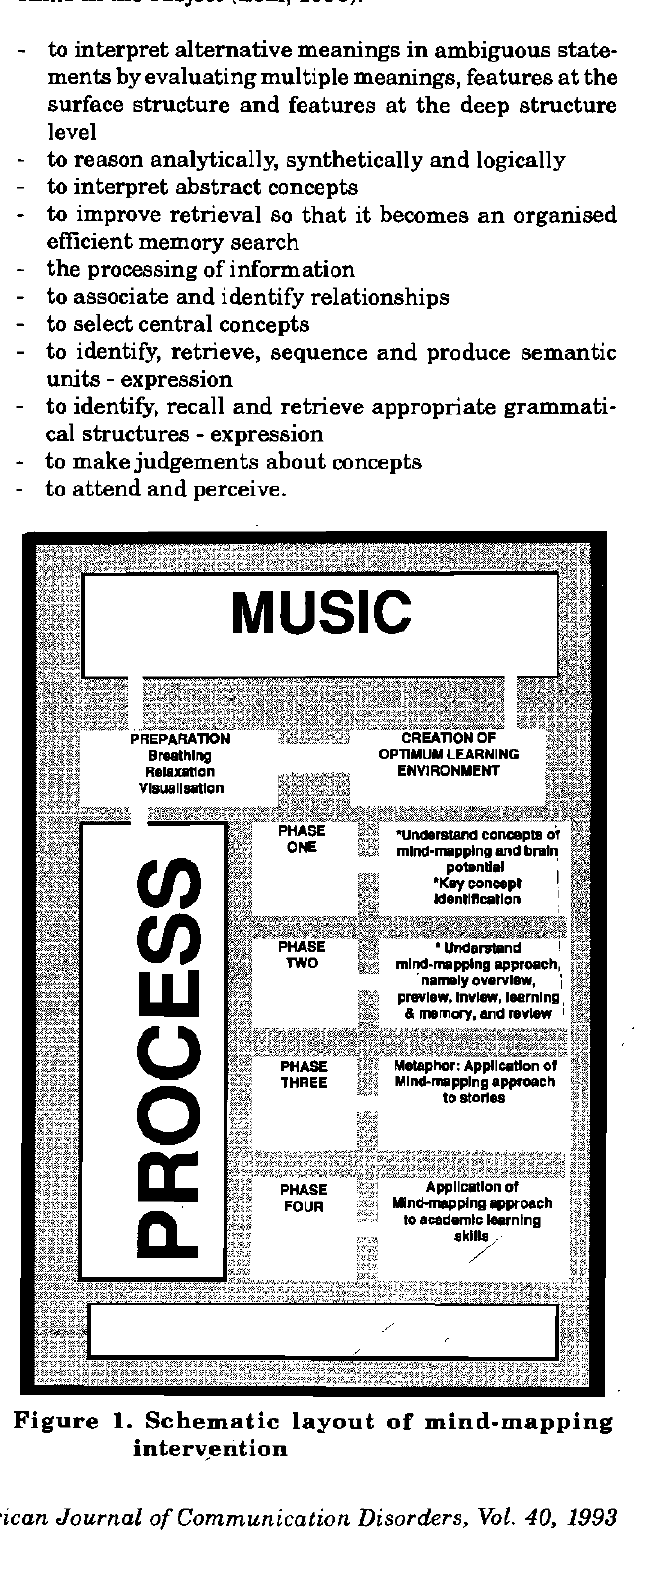
Figure 1. Schematic layout of mind-mapping intervention